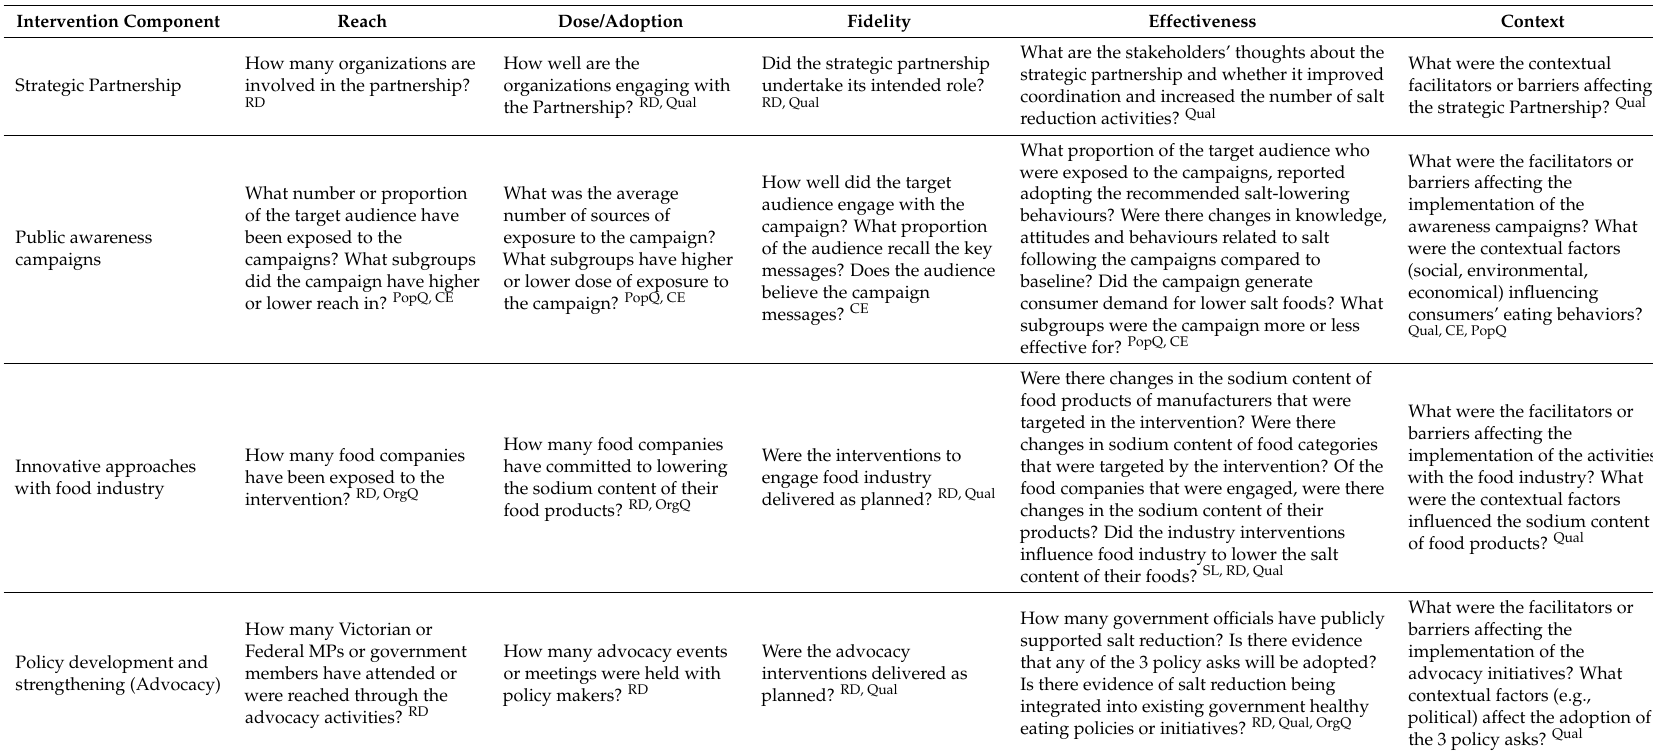
Table 2. Process evaluation dimensions, research questions and data collection